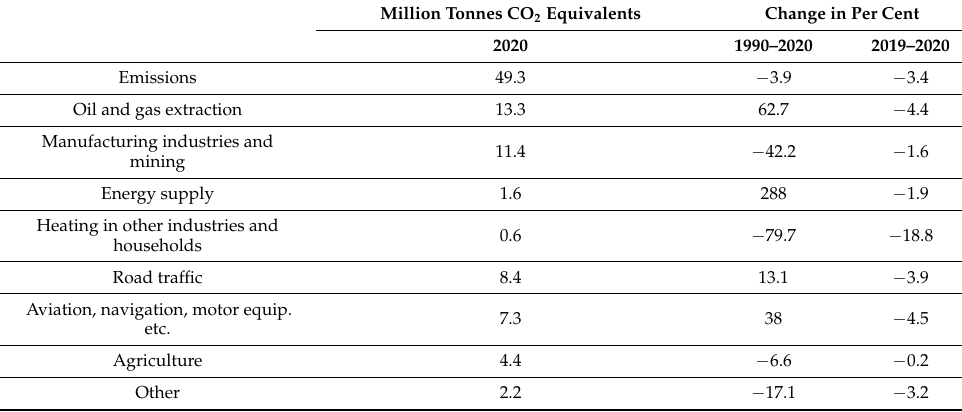
Table 2. Greenhouse gas emissions in Norway 1